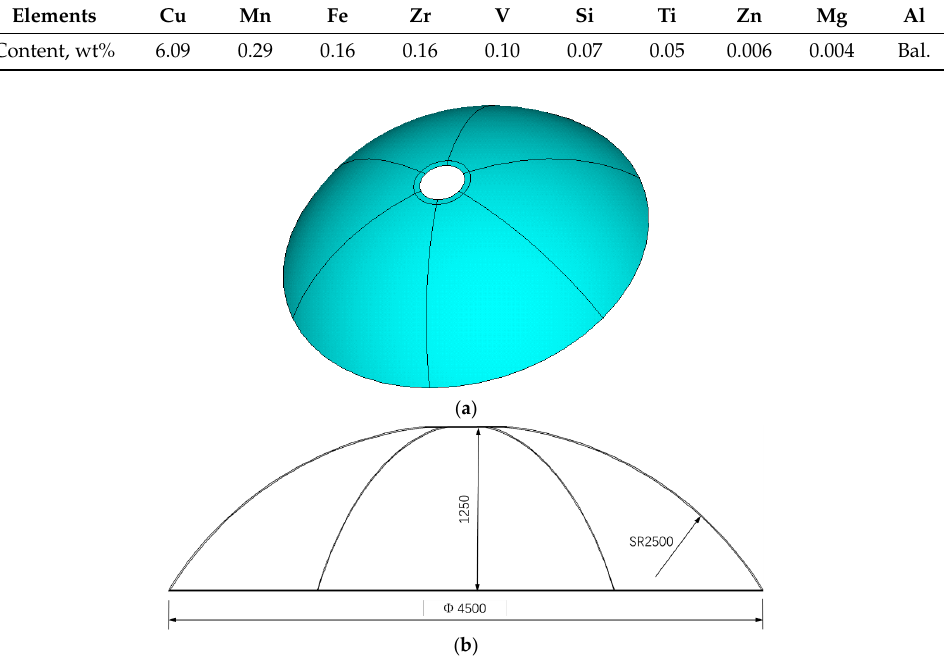
Figure 1. Shape and dimensions of the spherical shell ring structure: ( a ) shape of the structure; and ( b ) dimensions of the structure (unit: mm).